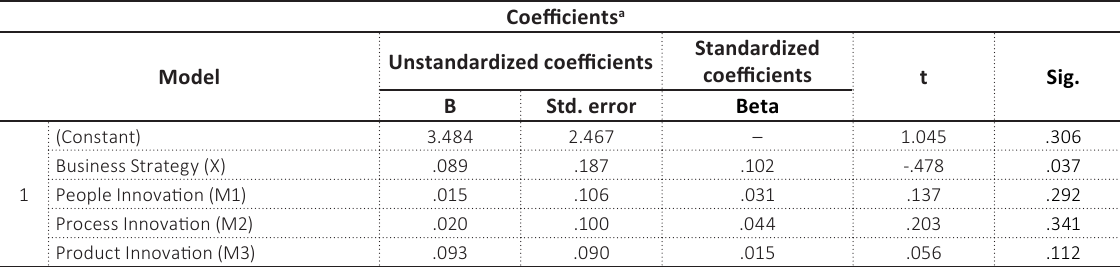
Table 8. Glejser’s heteroscedasticity for the 2 nd